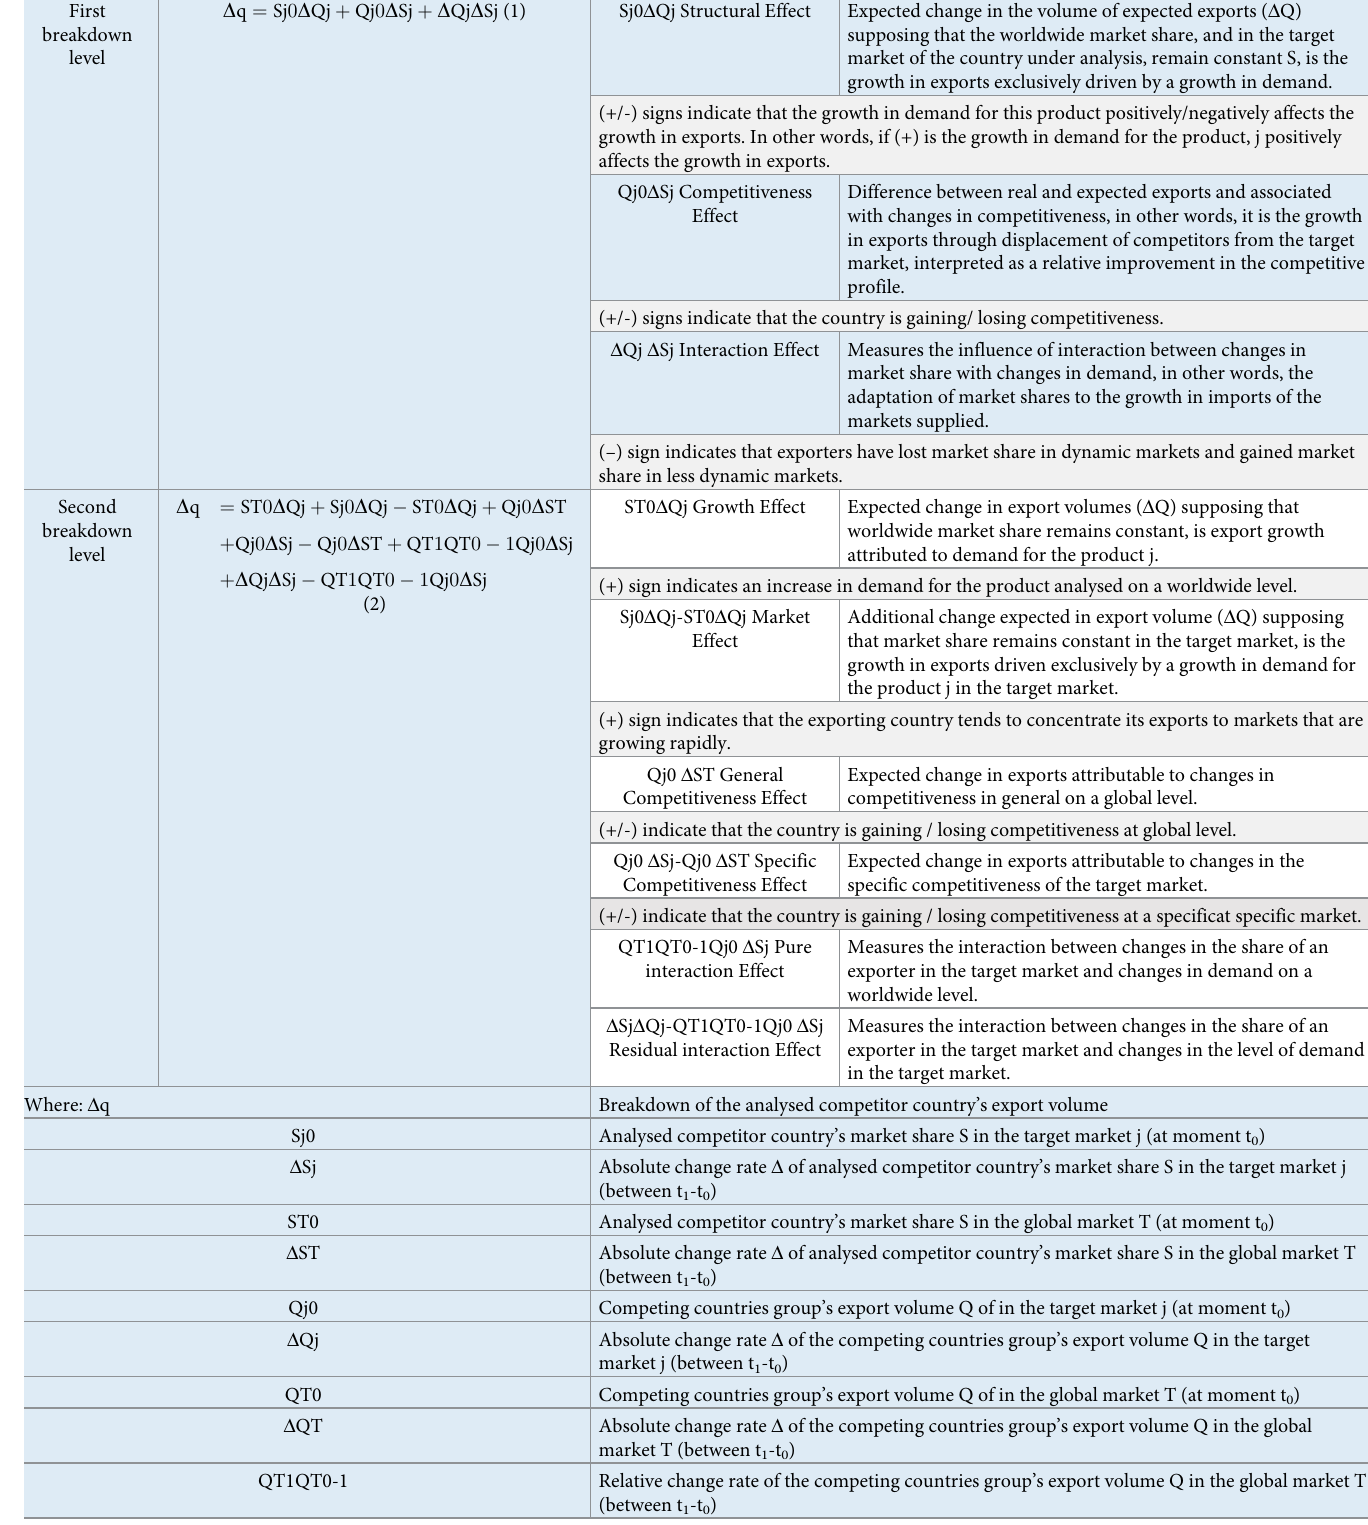
Table 1. Interpretation of different factors in the first and second level of exports decomposition of a region, country or commercial area makes in a target market. First breakdown